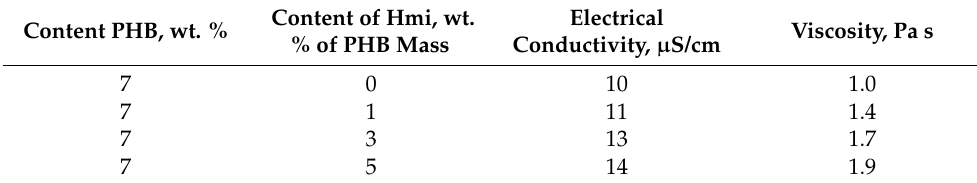
Table 2. The properties of the forming